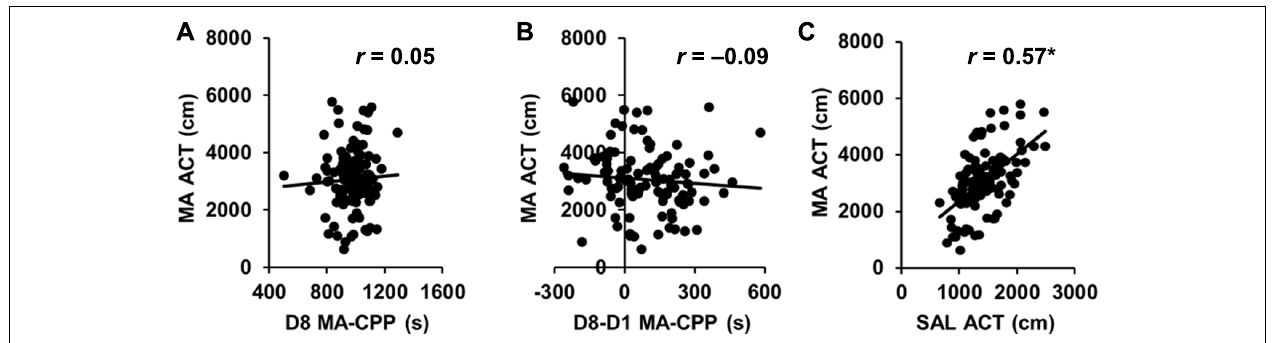
FIGURE 4 | No correlation of MA-CPP with MA-ACT inAIL mice. (A,B) Scatterplot of the average amount of MA-induced locomotor activity on D2 and D4 of training (MA-ACT) versus the time spent on the drug-paired side on D8 ( A ; D8 MA-CPP) or versus the difference in time spent on the MA-paired